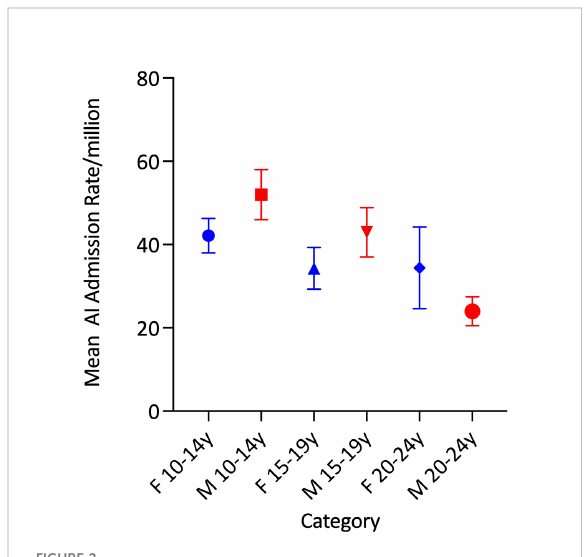
FIGURE 2 Mean total adrenal insuf fi ciency admission rates by age group and